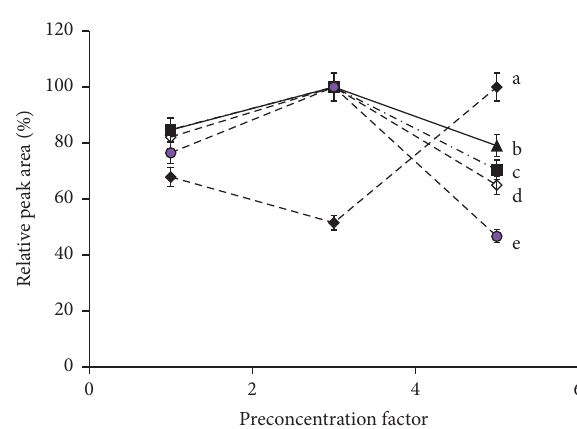
Figure 3: Effect of the preconcentration factor on some polycyclic aromatic hydrocarbons release from tea infusion to organic phase: a: indeno[1,2,3-cd]pyrene; b: benzo[a]pyrene; c: benzo[k]fluorant- hene; d: benzo[b]fluoranthene; e: benzo[ghi]perylene.